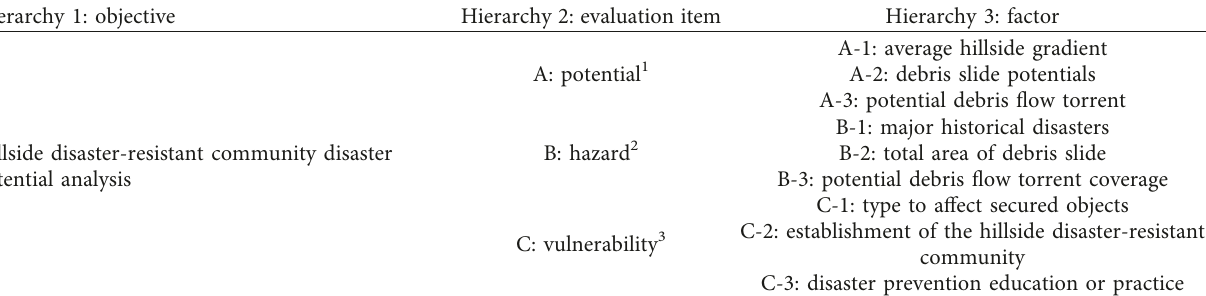
Table 2: Hierarchical structure for hillside disaster-resistant communities.